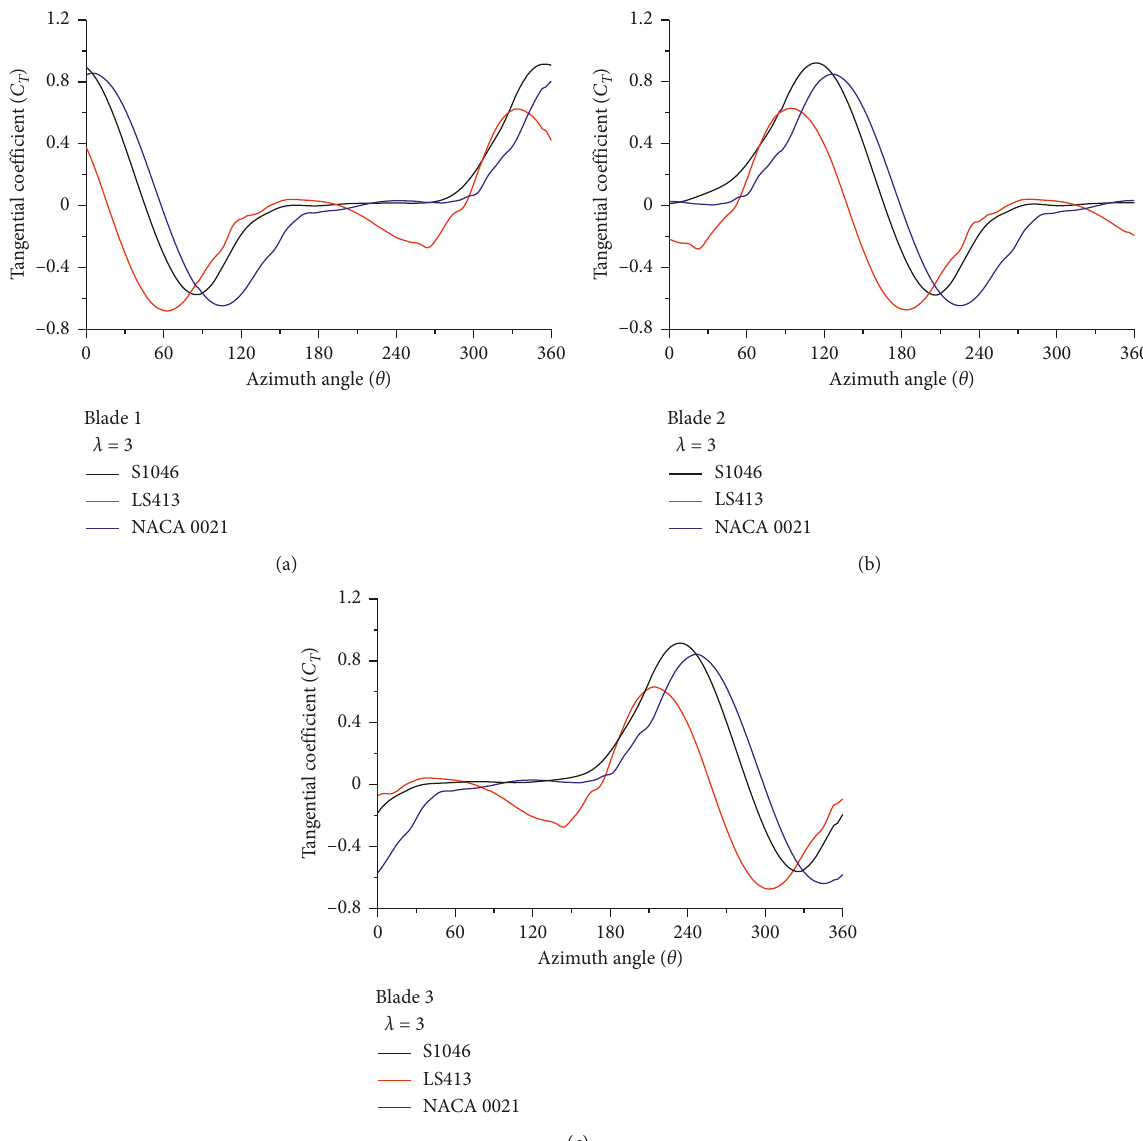
Figure 14: Instantaneous dynamic tangential force coefficients on the Darrieus rotor located at every